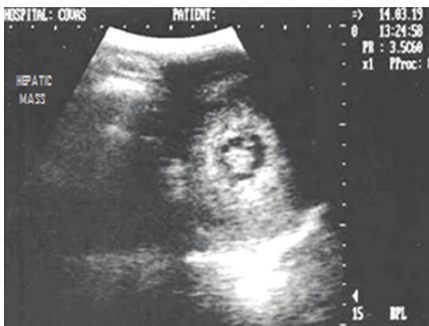
Figure 29: Lateral abdominal radiograph of an 8-year-old intact male, mixed-breed dog with cutaneous tumour and pulmonary metastasis demonstrating generalized hepatomegaly.